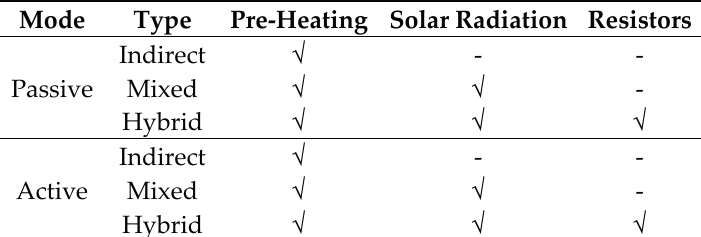
Figure 1. Solar dryer. Table 3. Operating modes of the solar dryer. √ , on; -,